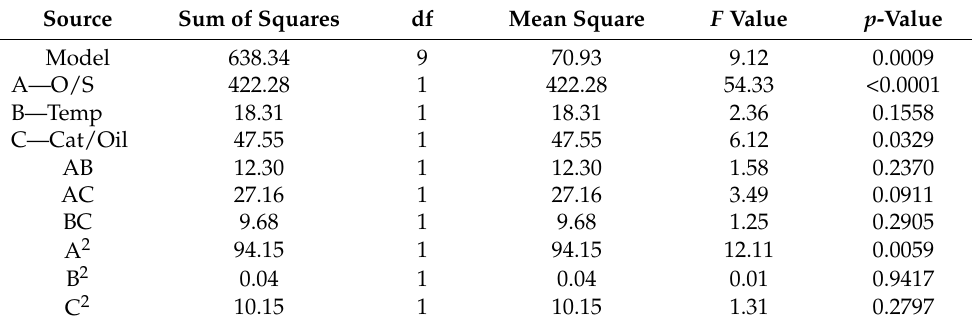
Table 5. ANOVA for ODS of tire pyrolysis oil over HPMo/Ti-TUD-1(0.025) catalyst.